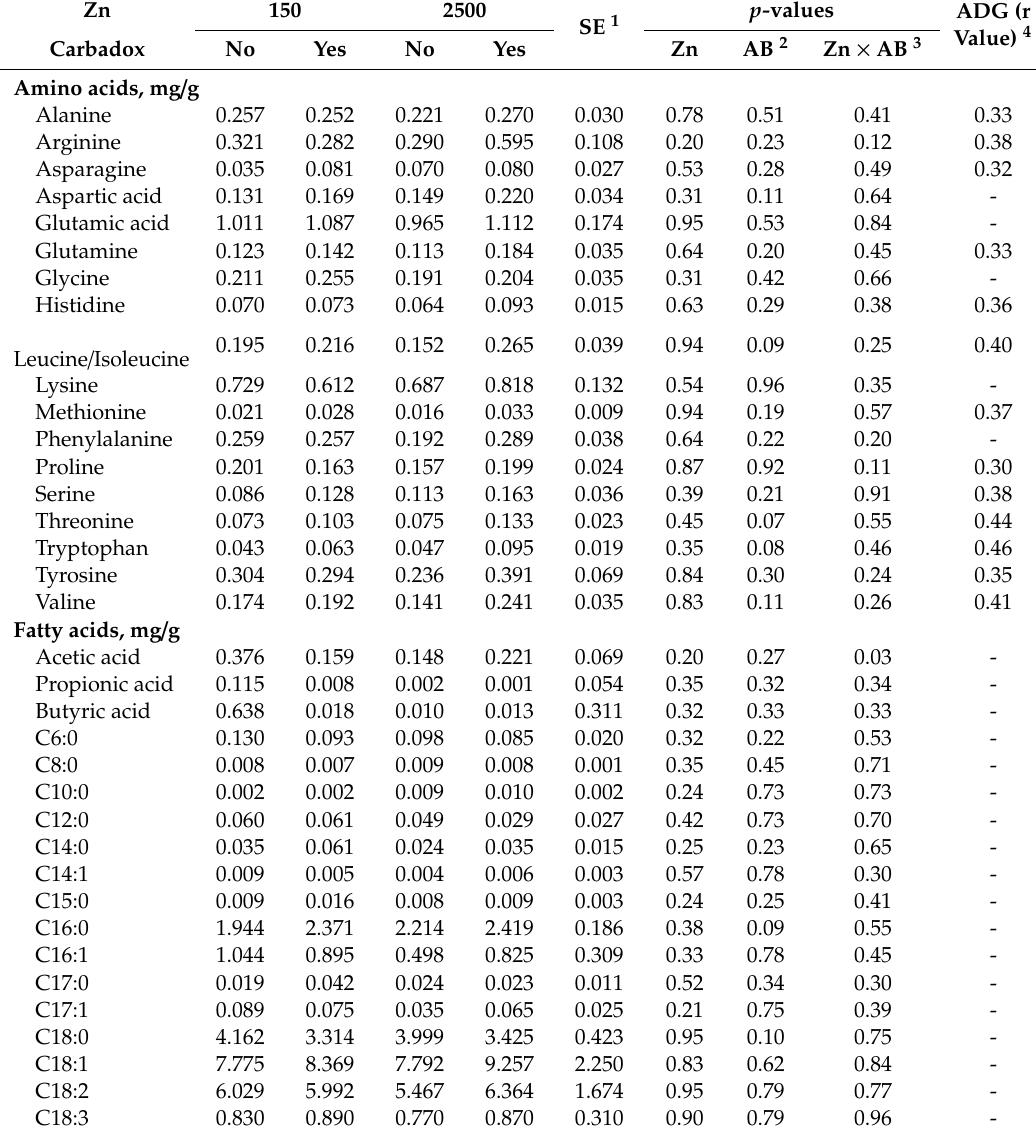
Table 3. E ff ect of Zn concentration and carbadox on amino acid (AA), fatty acid (FA), and bile acid (BA) in ileal